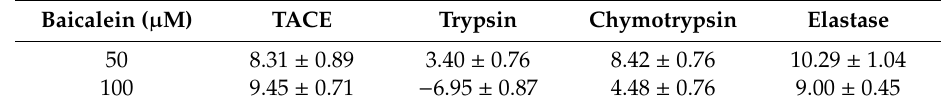
Table 2. Inhibitory activities (%) 1,2 of baicalein against α -secretase (TACE) and other serine